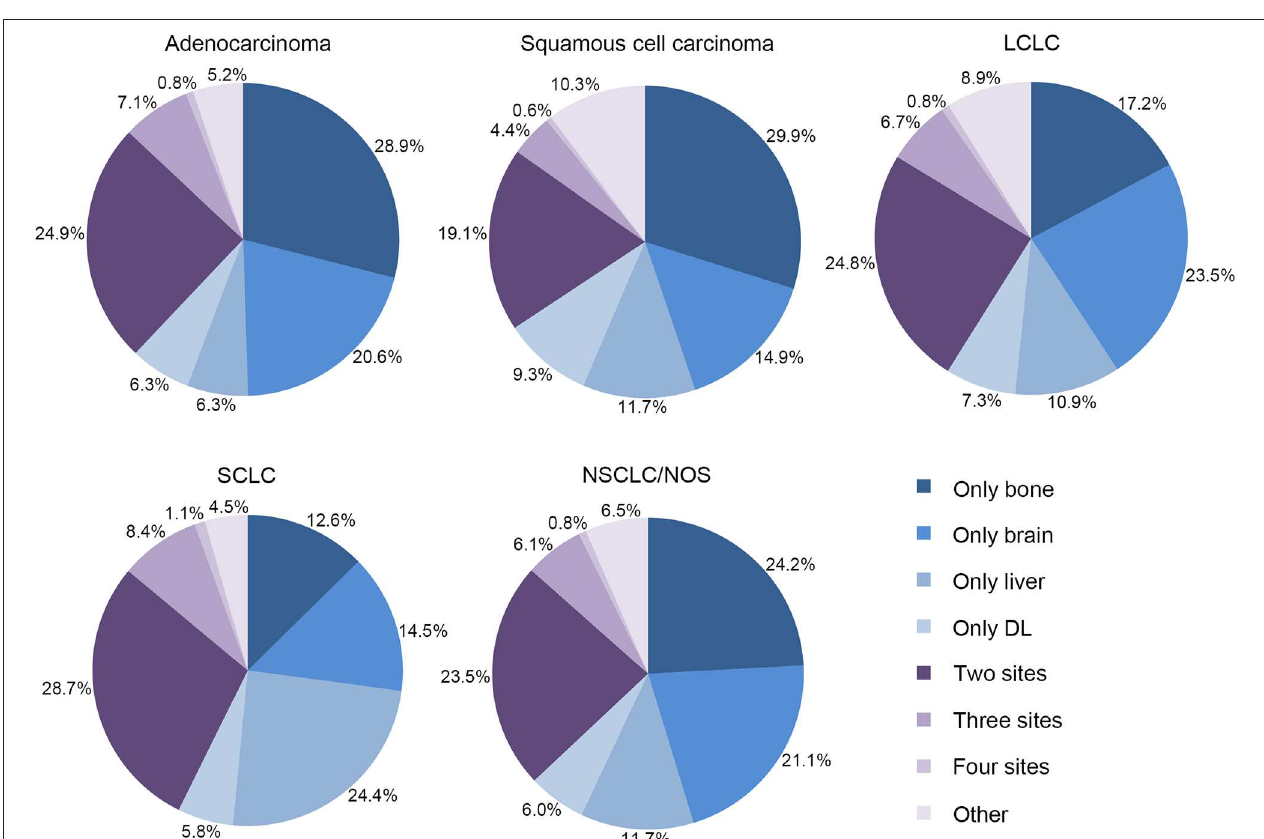
FIGURE 3 | Relative rates of single and combined metastatic sites in different histological types.